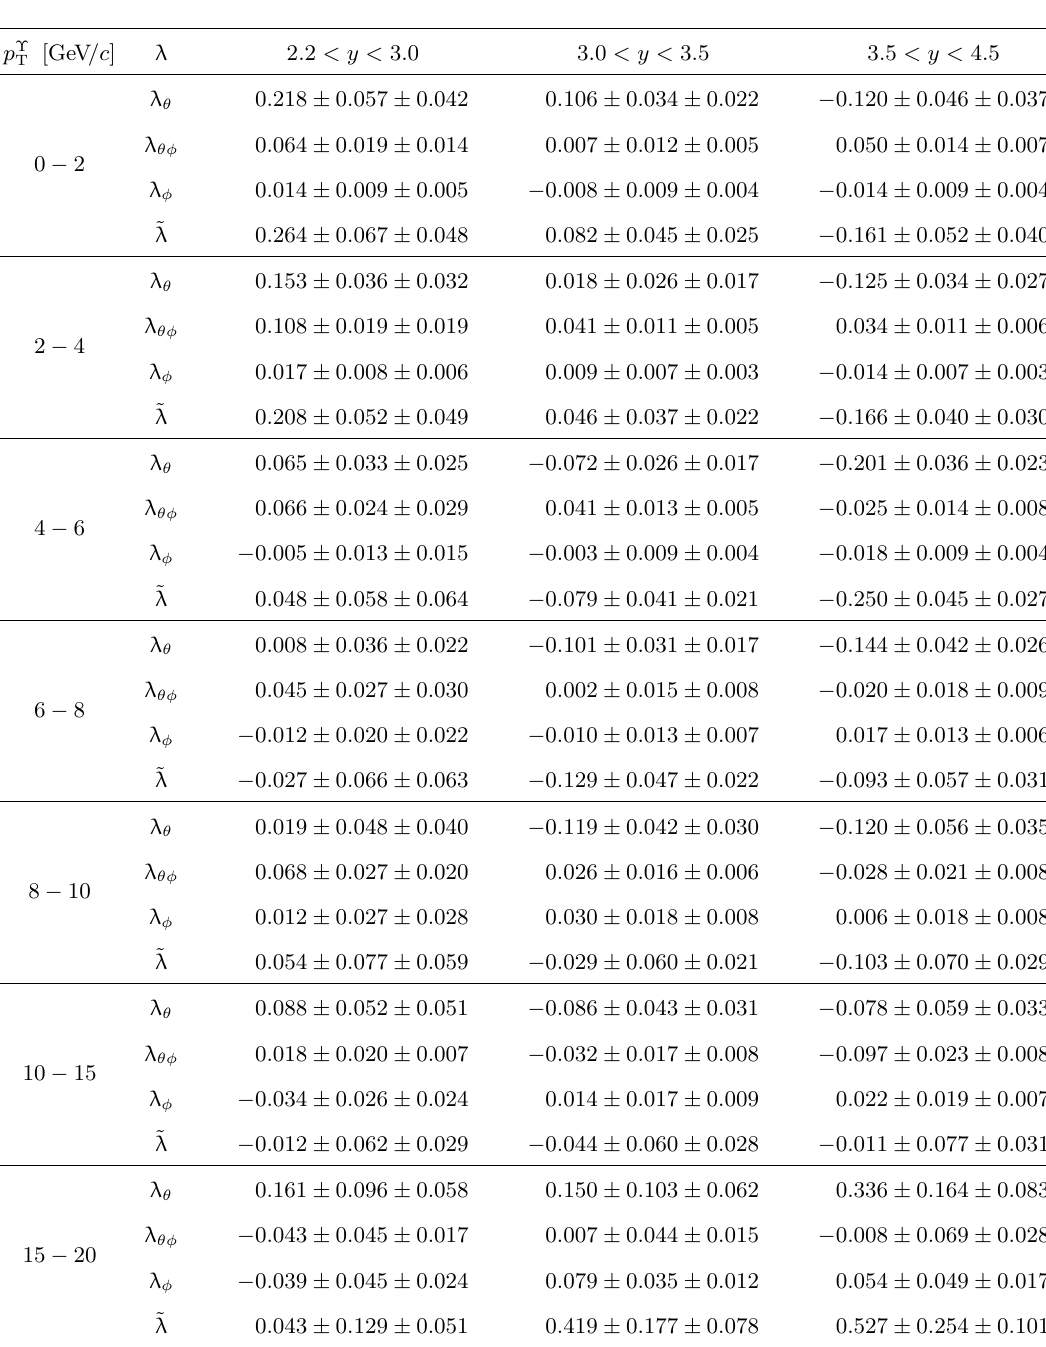
Table 6 . Values of (cid:21) (cid:18) , (cid:21) (cid:18)(cid:30) , (cid:21) (cid:30) and ~ (cid:21) measured in the GJ frame for the (cid:7)(1S) produced at p s = 7 TeV. The (cid:12)rst uncertainty is statistical and the second systematic.